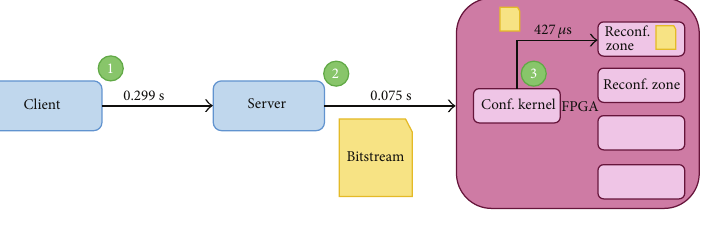
Figure 10: Reconfiguration time.